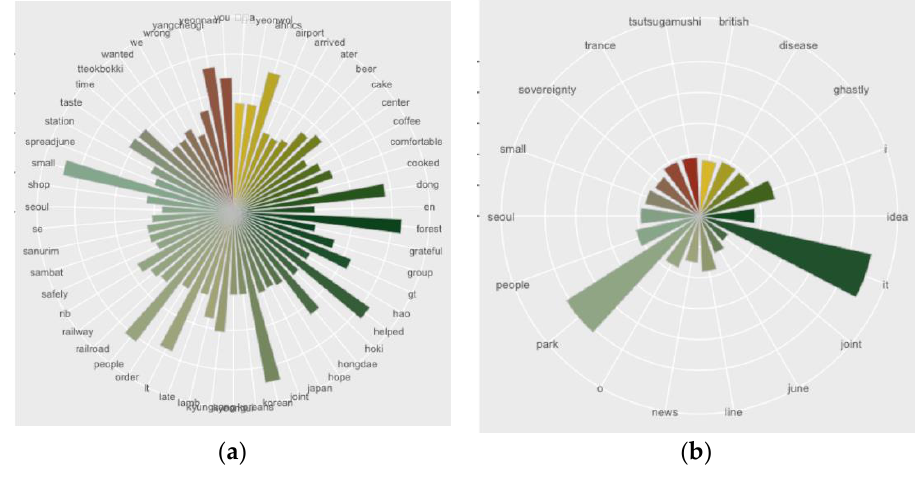
Figure 4. ( a ) Word frequency analysis of positive sentiments; ( b ) Word frequency analysis of negative sentiments.